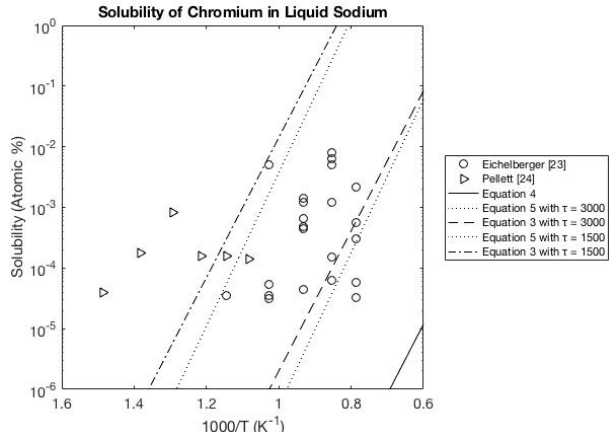
Figure 6. Solubility of chromium in liquid sodium.